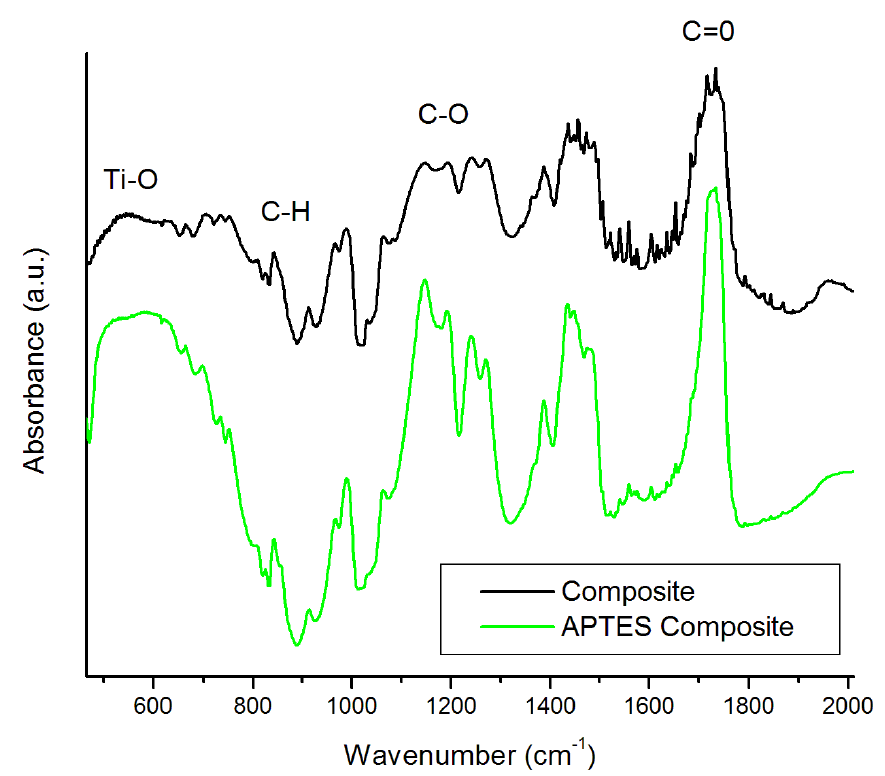
Figure 2. A comparison of FTIR spectra of the BTO50/poly(methyl) methacrylate (PMMA) composite to the APTES modified BTO50/PMMA